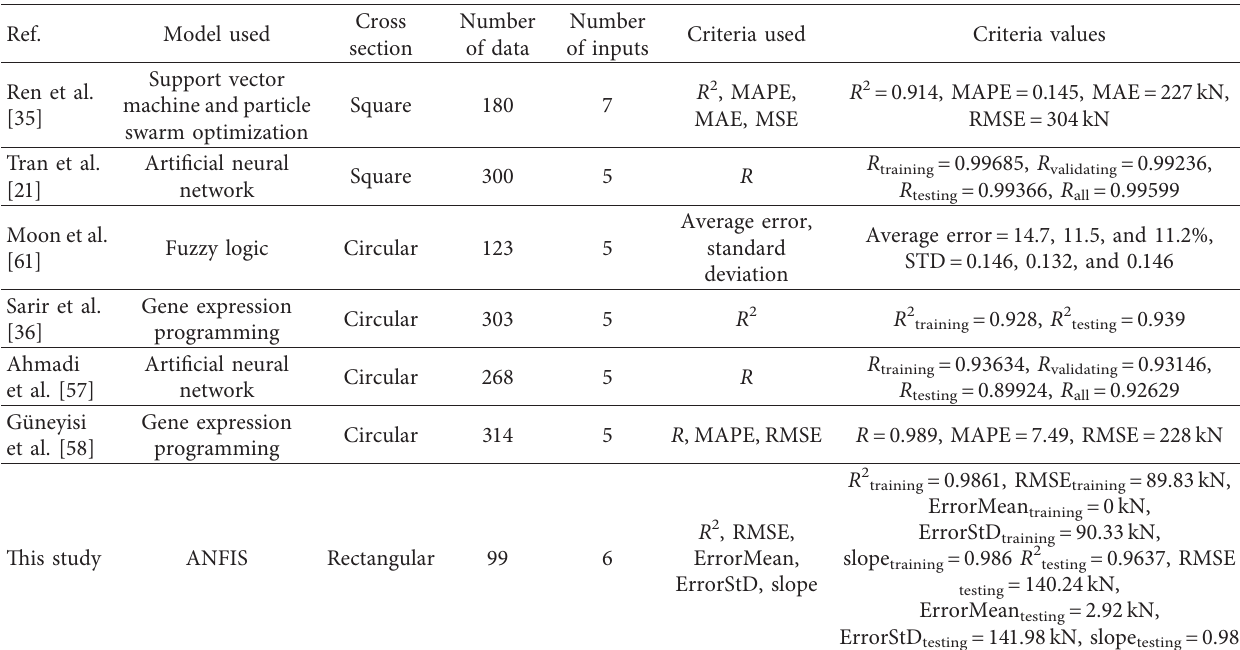
Table 5: Highlight of works for prediction of ultimate load of CFST members.